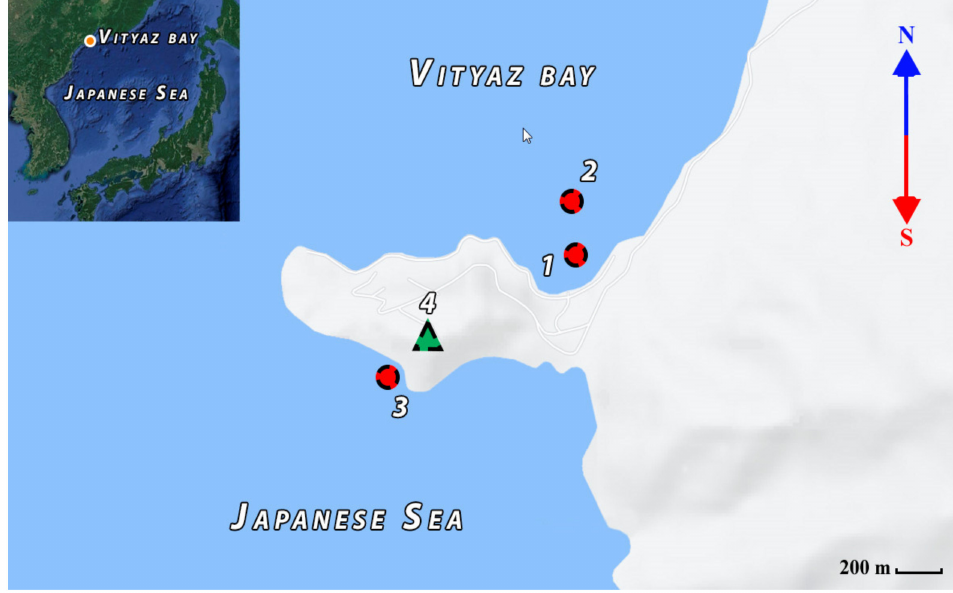
Figure 3. Map scheme of the experimental works. Points 1, 2, and 3 show the positions of laser meters of hydrosphere pressure variations, point 4 shows the position of laser